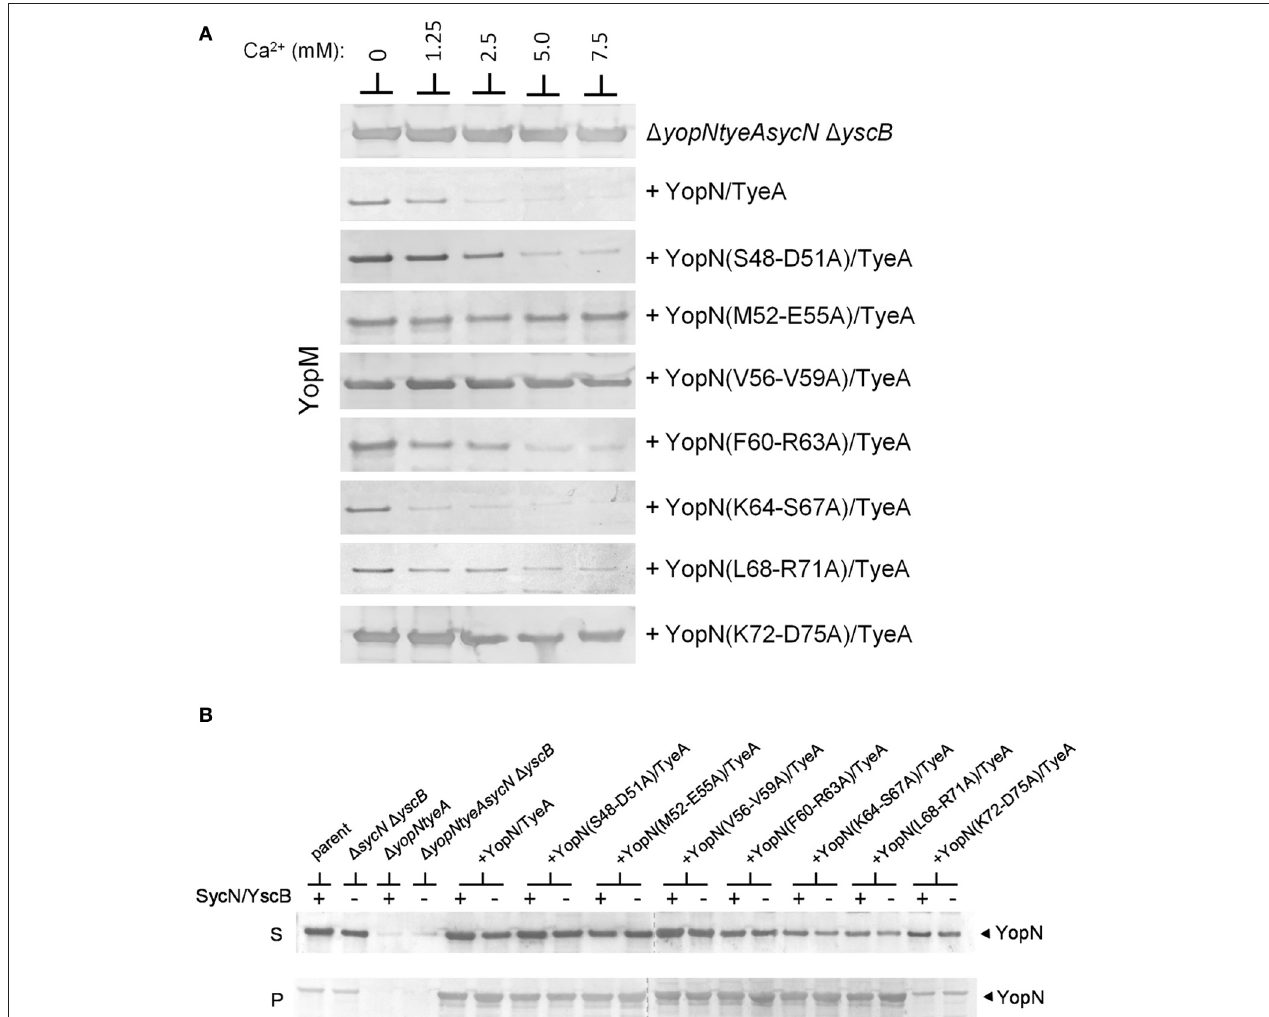
FIGURE 6 | Secretion of YopM by the YopN CBD tetra-alanine mutants under SycN/YscB chaperone-independentconditions. (A) Y. pestis KIM8-3001.PS2( (cid:2) yopN (cid:2) sycN (cid:2) yscB (cid:2) tyeA ) carrying pBAD18-YopN/TyeAor pBAD18-YopN/TyeAderivatives encoding one of the YopN CBD tetra-alanine mutants that previously exhibited a defect in the regulation of Yop secretion under normal SycN/YscB chaperone-dependentconditions were grown for 5h in the presence of 0mM, 1.25mM, 2.5mM, 5mM, or 7.5mM calcium. Expression of YopN, the YopN CBD tetra-alanine substitution mutants and TyeA from plasmid pBAD18-YopN/TyeAor derivatives of this plasmid was induced with 0.2% L-arabinose. (A) Secreted YopM was detected by